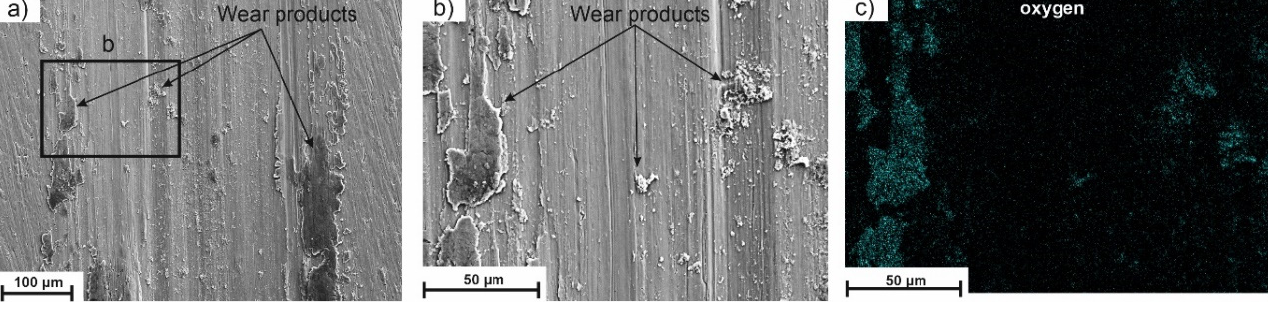
Figure 50. ( a ) SEM image of a wear track on AMZ4 fabricated via LPBF, ( b ) higher magnification of region b, and ( c ) EDS map of oxygen content in ( b ) [32].